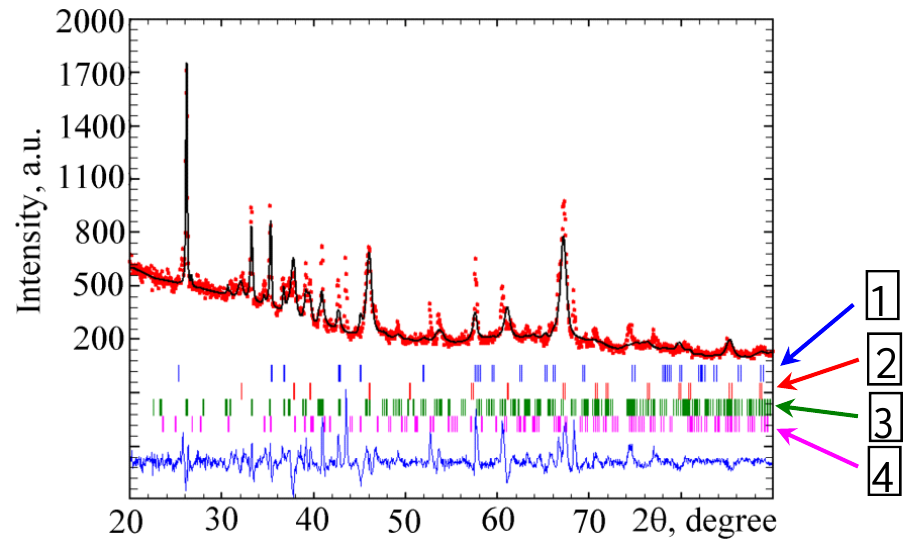
Figure 10. Structure of the PEO layer synthesized on AK12 alloy in 3 g/L KOH + 2 g/L Na 2 SiO 3 electrolyte.